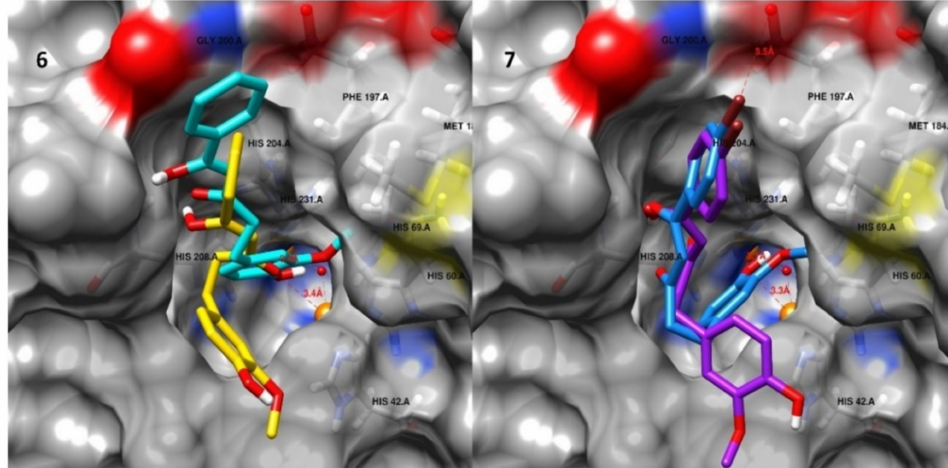
Figure 12. Representation of the best docking poses of compounds 6 and 7 surrounding the catalytic site where one copper ion is represented as orange ball. On the left : lowest energy (cyan) and the most populated pose (yellow) of compound 6 . On the right : lowest energy (light blue) and the most populated pose (purple) of compound 7